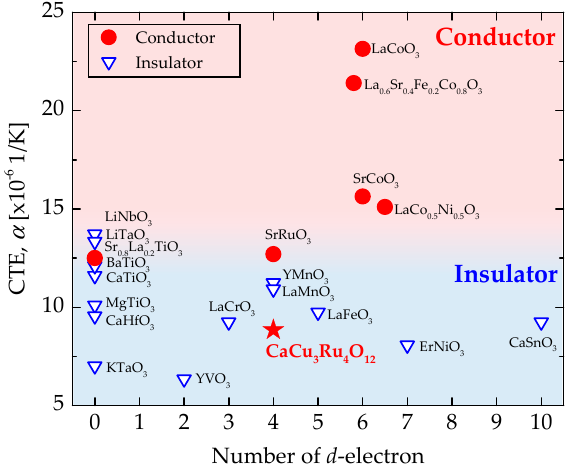
Figure 4. CTE of various perovskite oxides plotted as a function of the number of d-electrons.